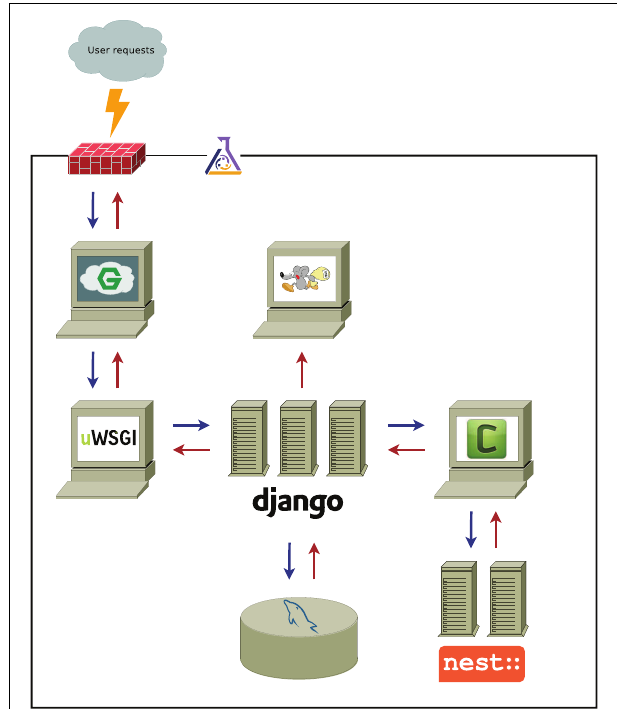
FIGURE 1 | Functional scheme of nu SPIC architecture. Black solid line represents the LAN (local area network) boundaries and the gray cloud symbolizes WAN (wide-area network); the firewall is denoted by the red brick wall. The flask shows that all infrastructure delimited by the black line is managed by Puppet. Computers are a metaphor for individual services, and, in particular, servers stand for services, that spawn a number of independent workers to concurrently processes incoming requests. The computer with the running mouse icon represents Postfix, the mail server, the meaning of other icons is explained in the main text. Arrows show the flow of communications between the components of the